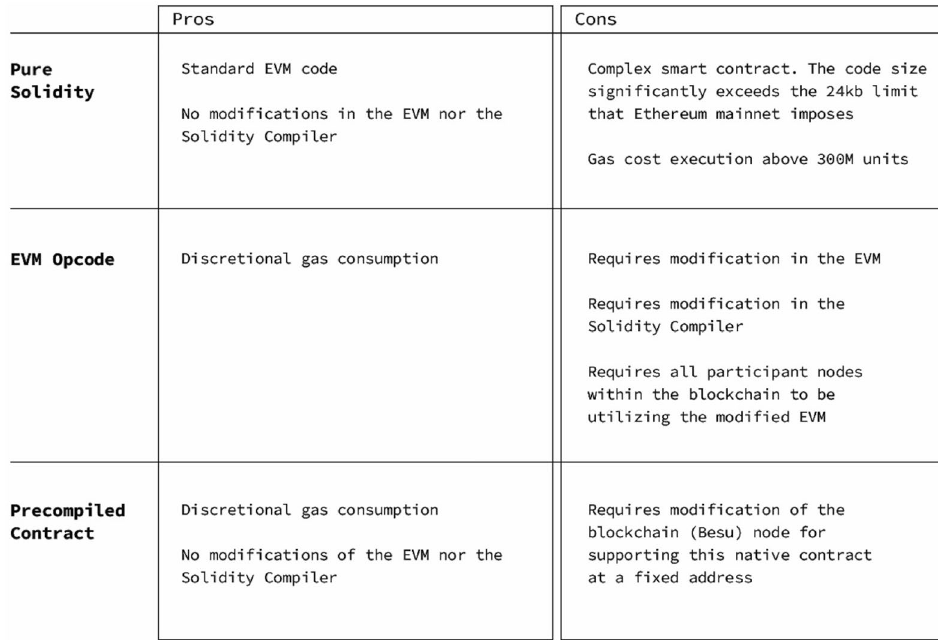
Figure 12. Pros and Cons of Pure Solidity, EVM Opcode, and Precompiled contract.